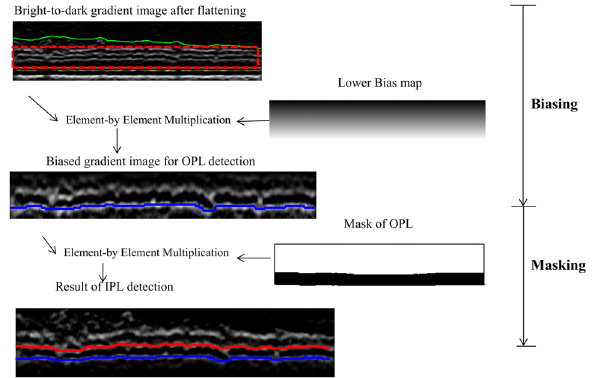
Fig 5. Illustration of the biasing and masking operations for the boundary detection of the IPL-INL (red) and OPL o (blue). The search region or ROI (red dotted rectangle) is the area between IS-OS and ILM (green solid lines). After element-by-element multiplication with lower bias map, the OPL o is more prominent in the gradient image and can be detected easily. A binary mask is generated to set all the pixels below OPL o to zeros and the second lowest boundary, IPL-INL, is detected using the shortest-path graph